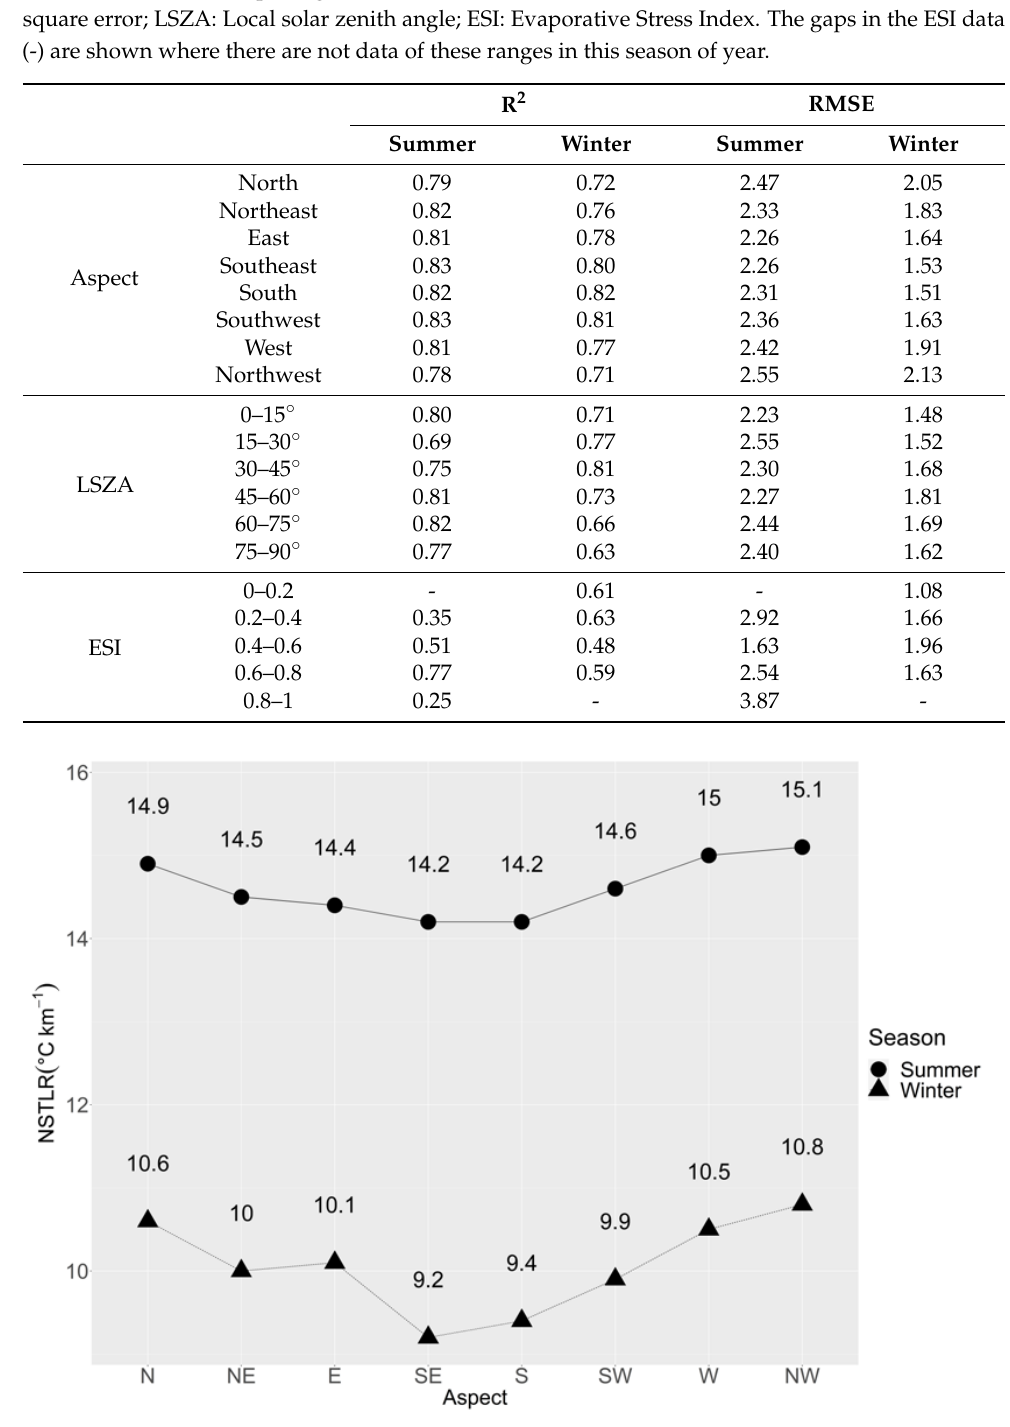
Figure 6. Temperature lapse rate of the two seasons at different Local solar zenith angle.